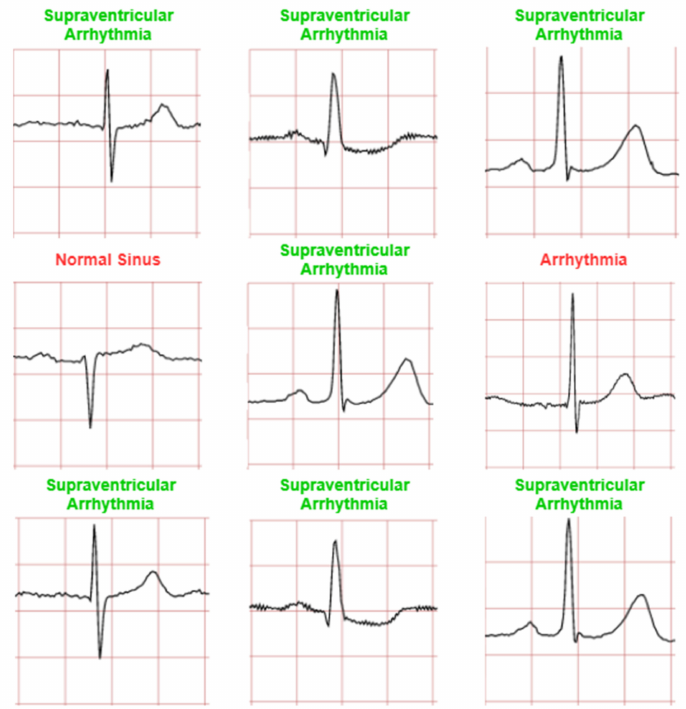
Figure 14. Prediction for ‘supraventricular arrhythmia’ ECG waveforms. (Note: red and green title indicated incorrect and correct prediction,